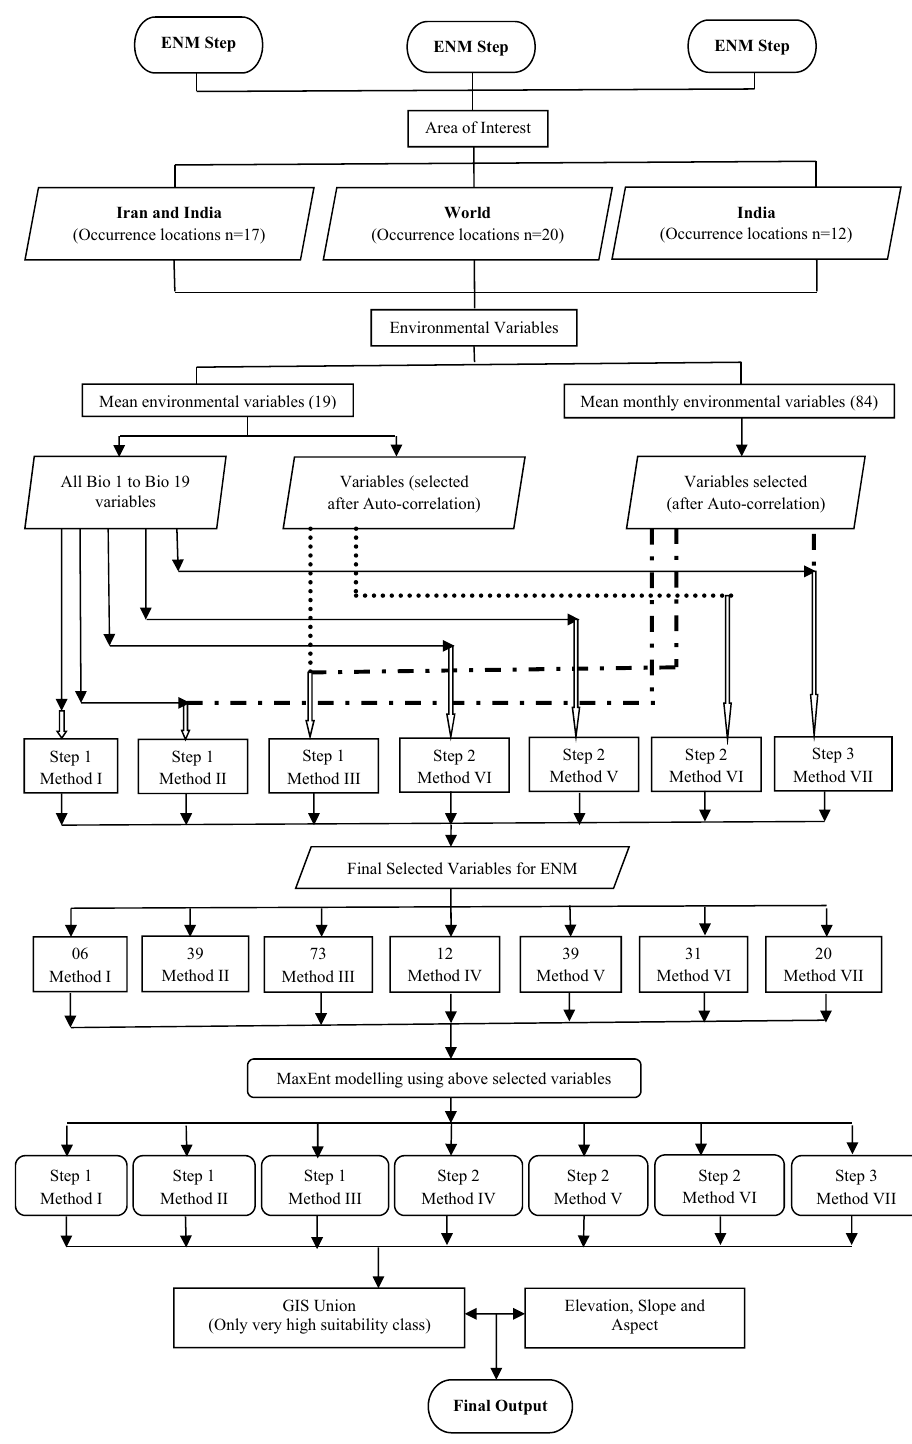
Figure 4. Flow chart of the methodology followed in the